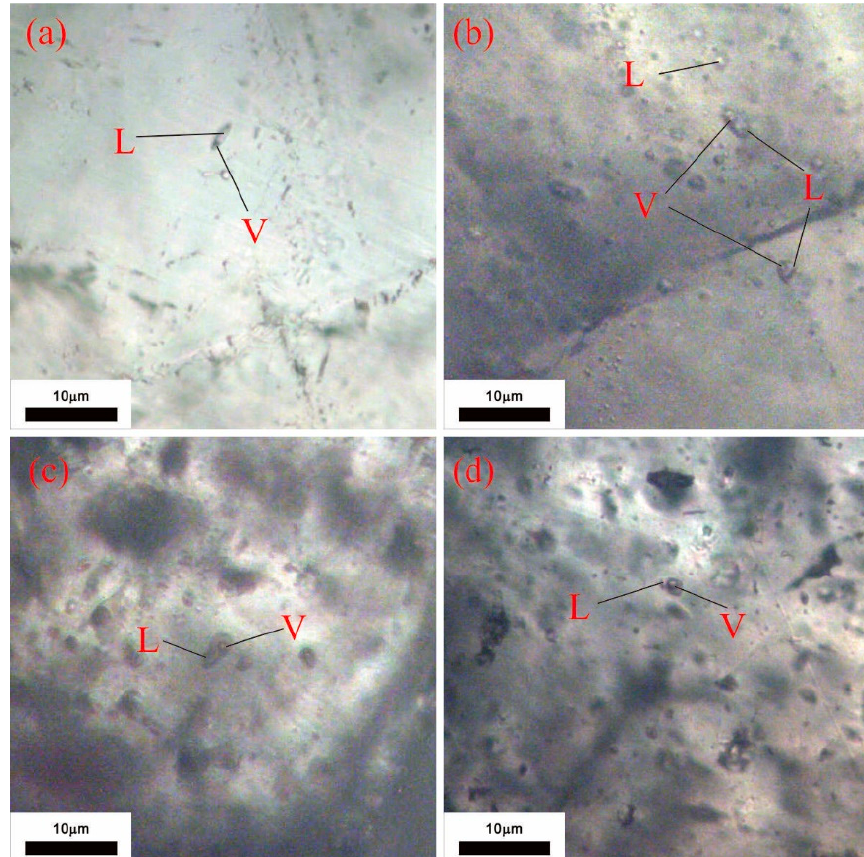
Figure 8. Microphotographs of fluid inclusions (FIs) from the Xianglushan Fe-Cu deposit: L—liquid phase; V—vapor phase. ( a ) Stage II V-L-type FIs; ( b ) Stage II L- and V-L-type FIs; ( c ) Stage III elongated V-L type FIs (bubble: 10 vol.%) ( d ) Stage III rounded V-L-type FIs (bubble: 30 vol.%).